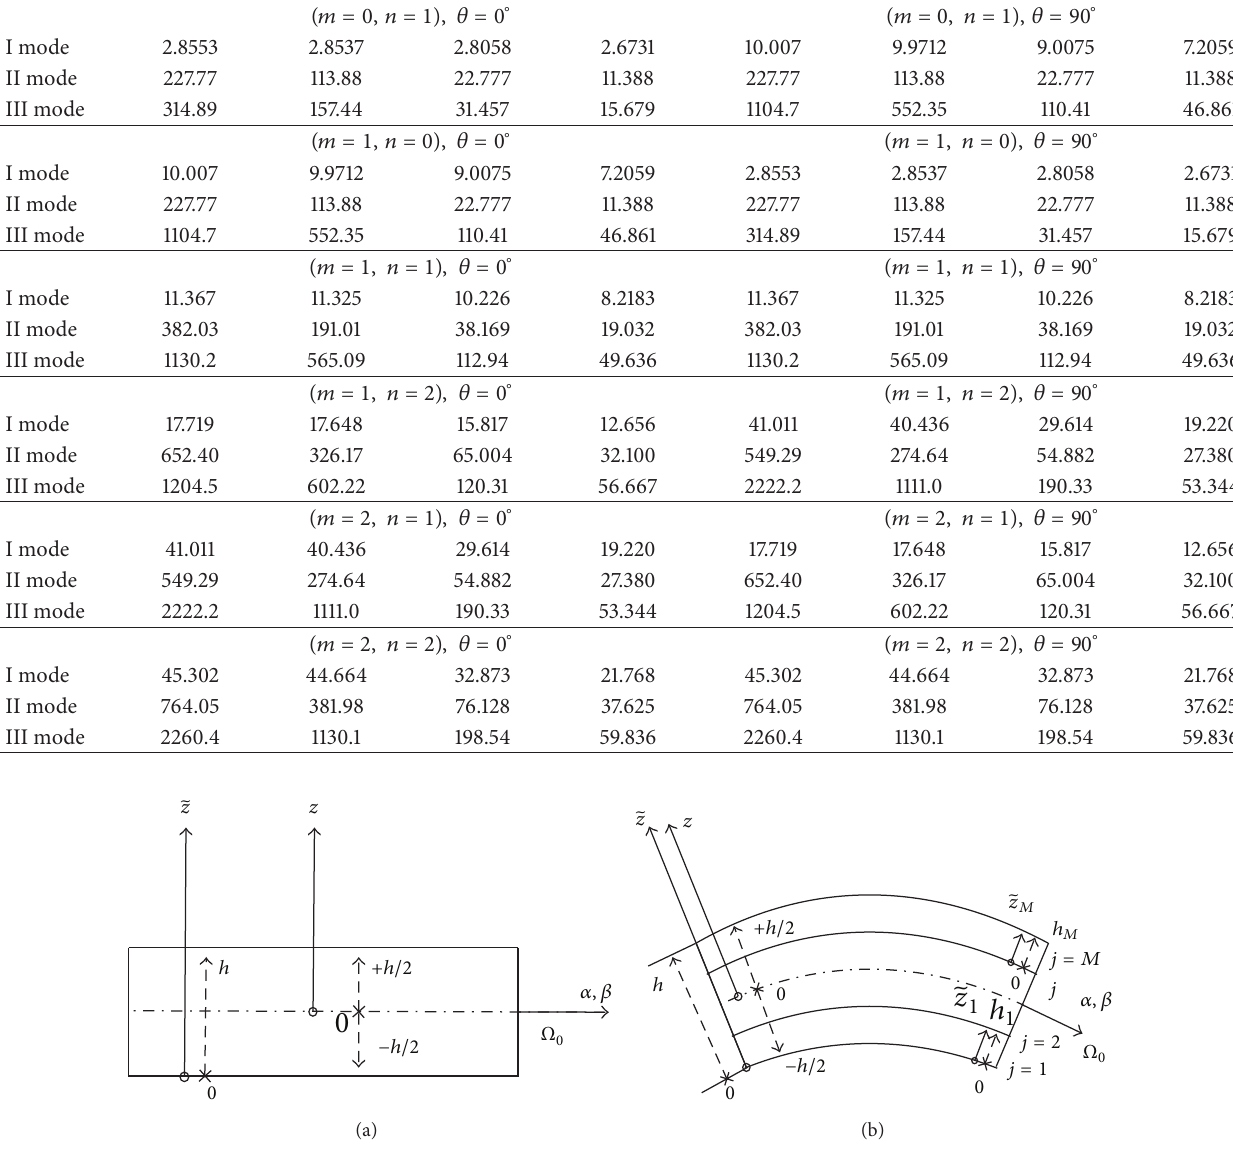
Figure 2: Thickness coordinates for plates and